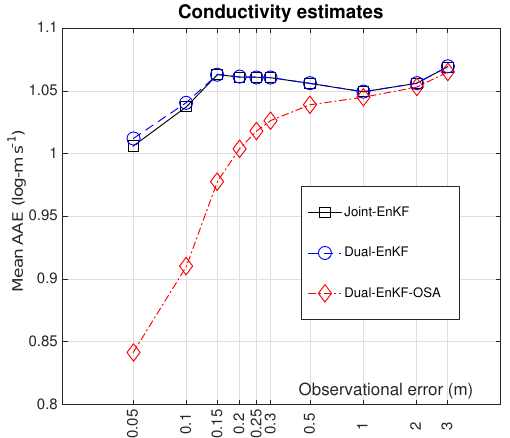
Figure 9. Mean AAE of the hydraulic conductivity using the joint EnKF, dual EnKF, and dual EnKF OSA schemes. Results are shown for 10 different scenarios in which assimilation of hydraulic head data is performed using nine wells with measurement error standard deviations of 0.05, 0.10, 0.15, 0.20, 0.25, 0.3, 0.5, 1, 2, and 3m. The four experimental scenarios use 100 ensemble members and 5 days as sampling period. The x axis is displayed in log